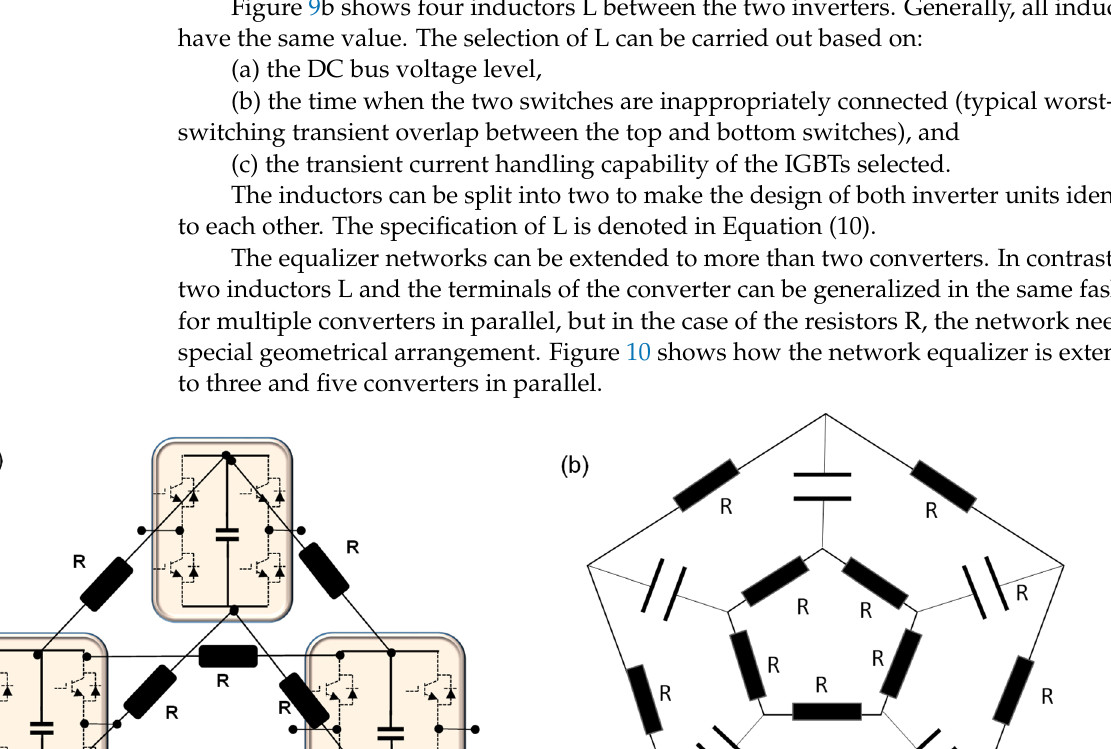
Figure 9. Embedding paralleling strategy from dices to modules to converters with inductive and resistive balancing network (R and L). ( a ) Four parallel modules form one IGBT; ( b ) One converter leg (red dotted line on panel b) is formed by four modules as indicated in top portion of panel a, or bottom circuit diagram of panel a